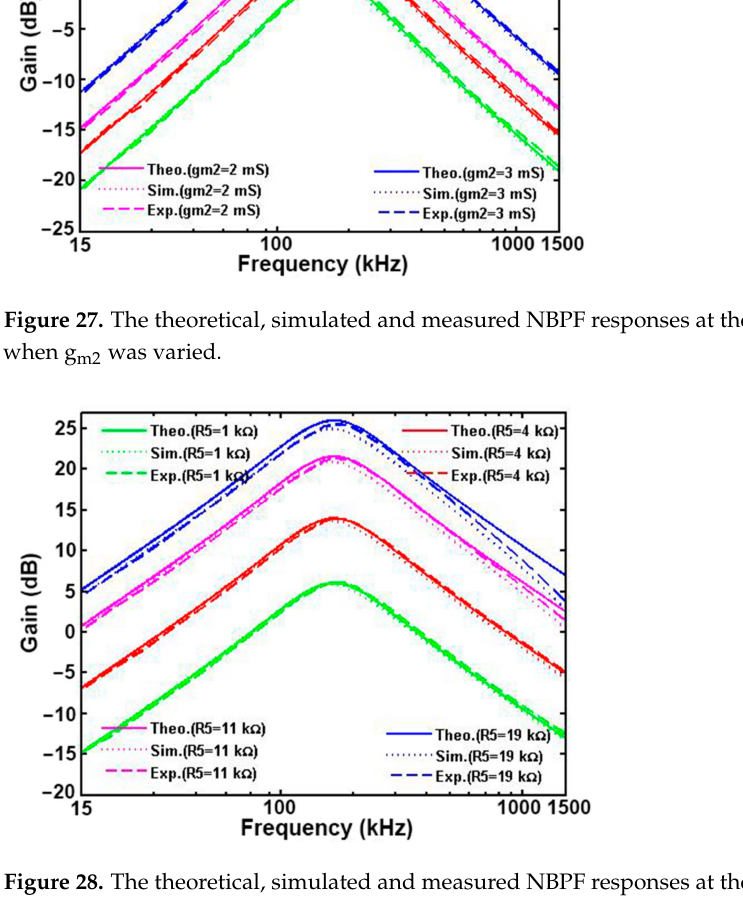
Figure 30. The measured magnitude responses of the V BP6 when R 5 was varied.